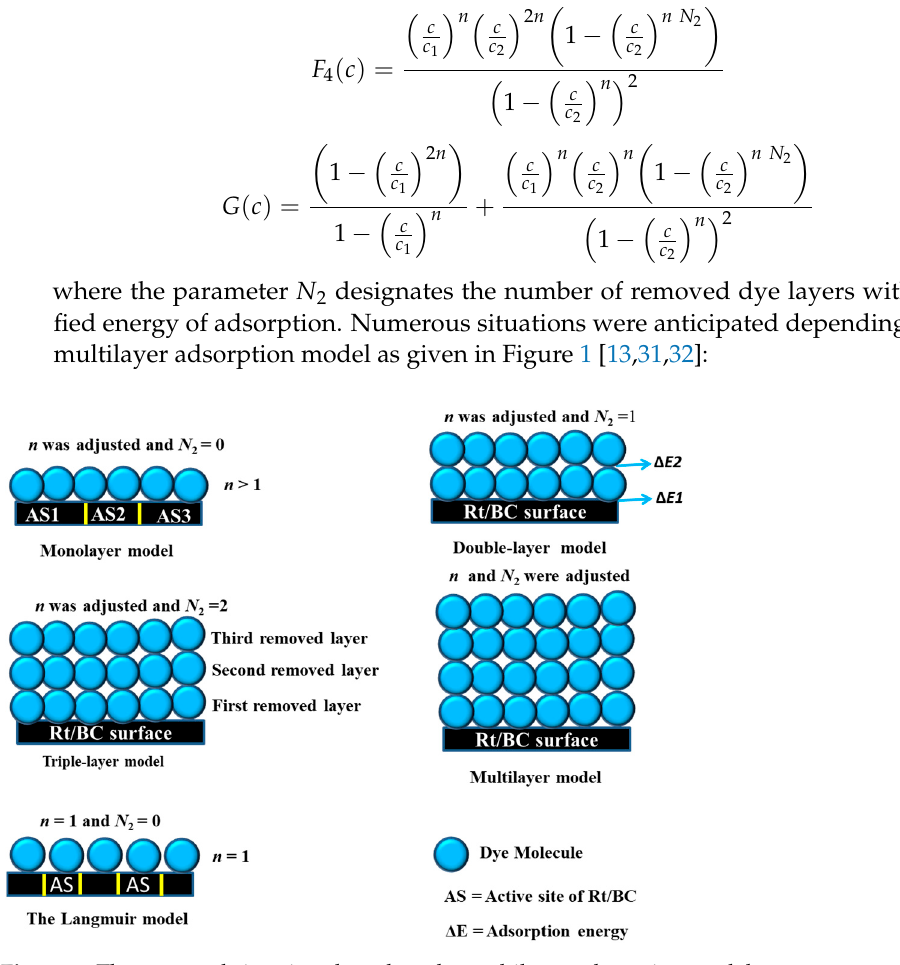
Figure 1. The expected situations based on the multilayer adsorption model.